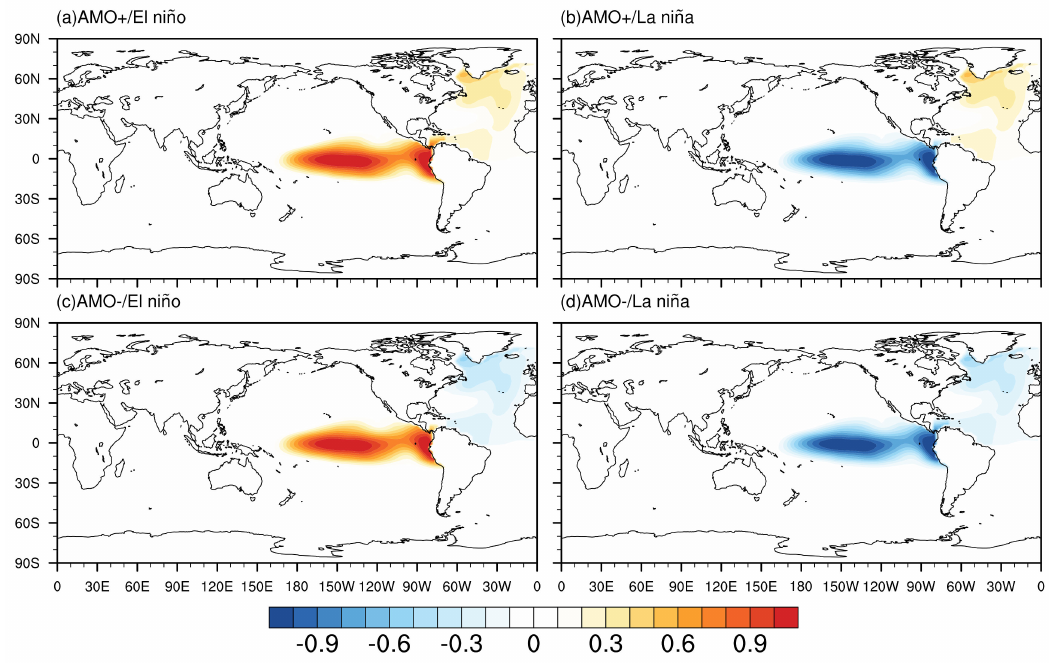
Figure 1. Spatial distribution of the SST anomalies (shading; units: ◦ C) in February imposed on the: ( a ) AMO+/El Niño; ( b ) AMO − /La Niña; ( c ) AMO − /El Niño; and ( d ) AMO − /La Niña